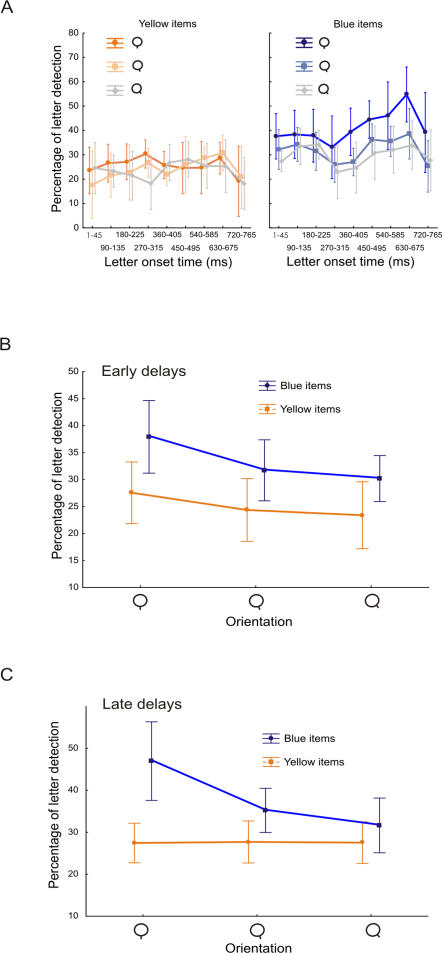
Effect of color and orientation of the CVS items on letter detection performance.A. Triple interaction orientation – color – letter onset time with letter detection performance as dependent variable. The Y-axis represents letter detection probability and the X-axis, letter-onset times with 90 ms intervals. The left and right graphs are for yellow (non target color) and blue (target color) items respectively. Color code is for orientation. The more saturated color corresponds to vertical (target orientation), the gray color corresponds to the most dissimilar distractor orientation, and the intermediate color is for the most similar distractor orientation. B. orientation – color interaction for early delays. The Y-axis represents letter detection probability, the X-axis the orientation of the items and the color code identifies the color of the item. C. orientation – color interaction for late delays. Same convention as in B.